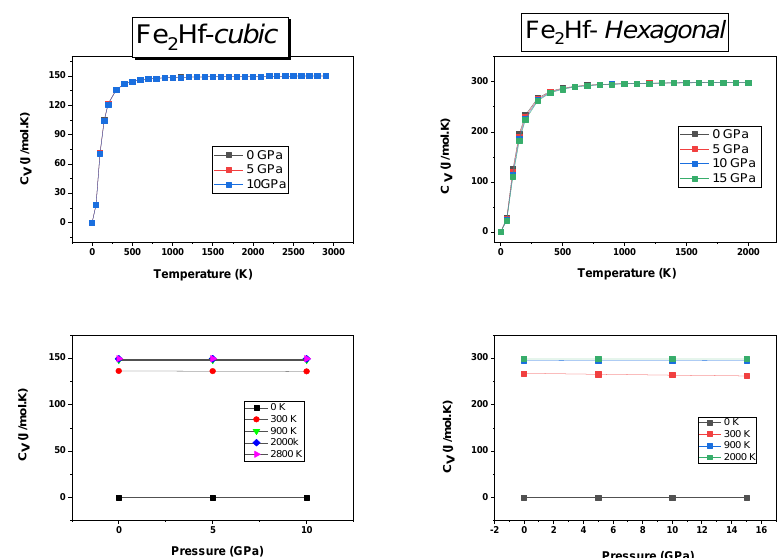
Fig. 10. Variation of constant volume heat capacity C V with temperature T and pressures for c- Fe 2 Hf and h- Fe 2 Hf (upper panel), respectively.